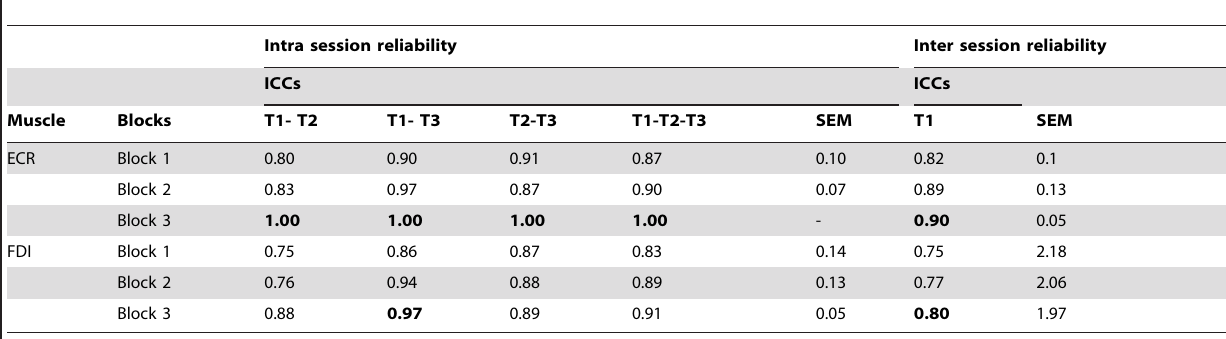
Table 4. Comparison of between MEPs correlation of the recorded MEPs latency from ECR and FDI muscles.